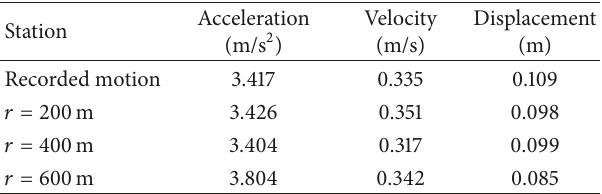
Table 1: Peak values of the simulated and recorded ground motions.